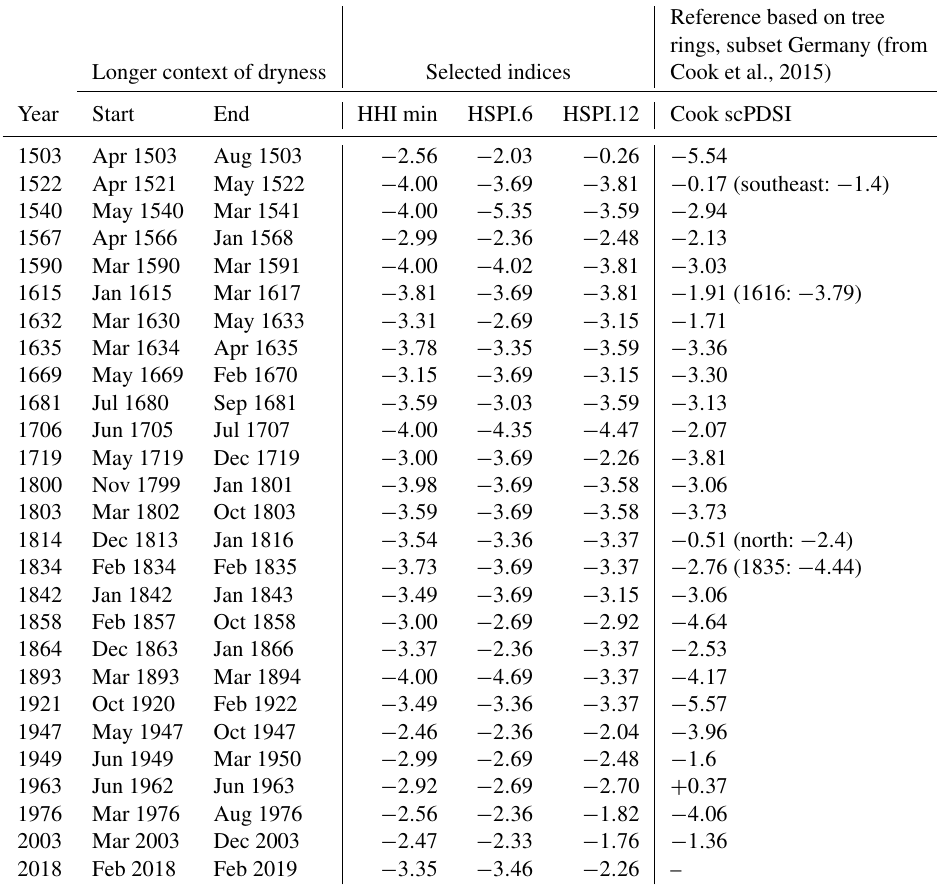
Reference based on tree rings, subset Germany (from